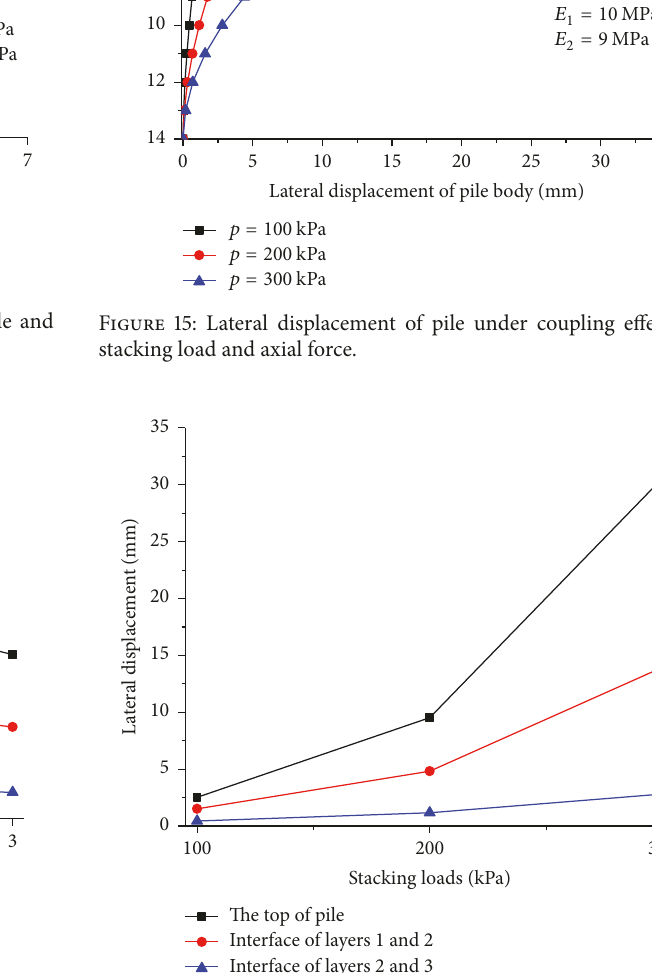
Figure 16: Lateral displacement of pile at different positions under coupling